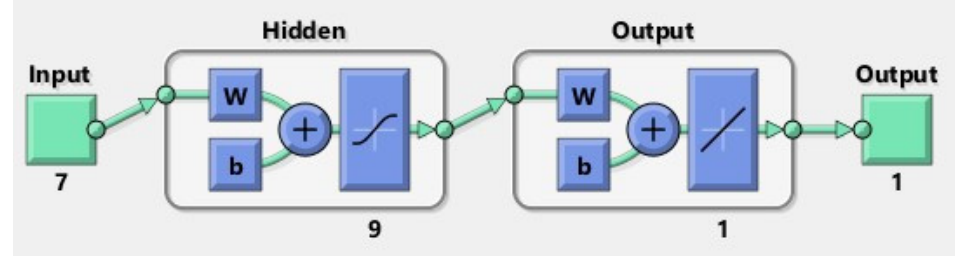
Figure 4. The symbolic architecture of an MLP network model.